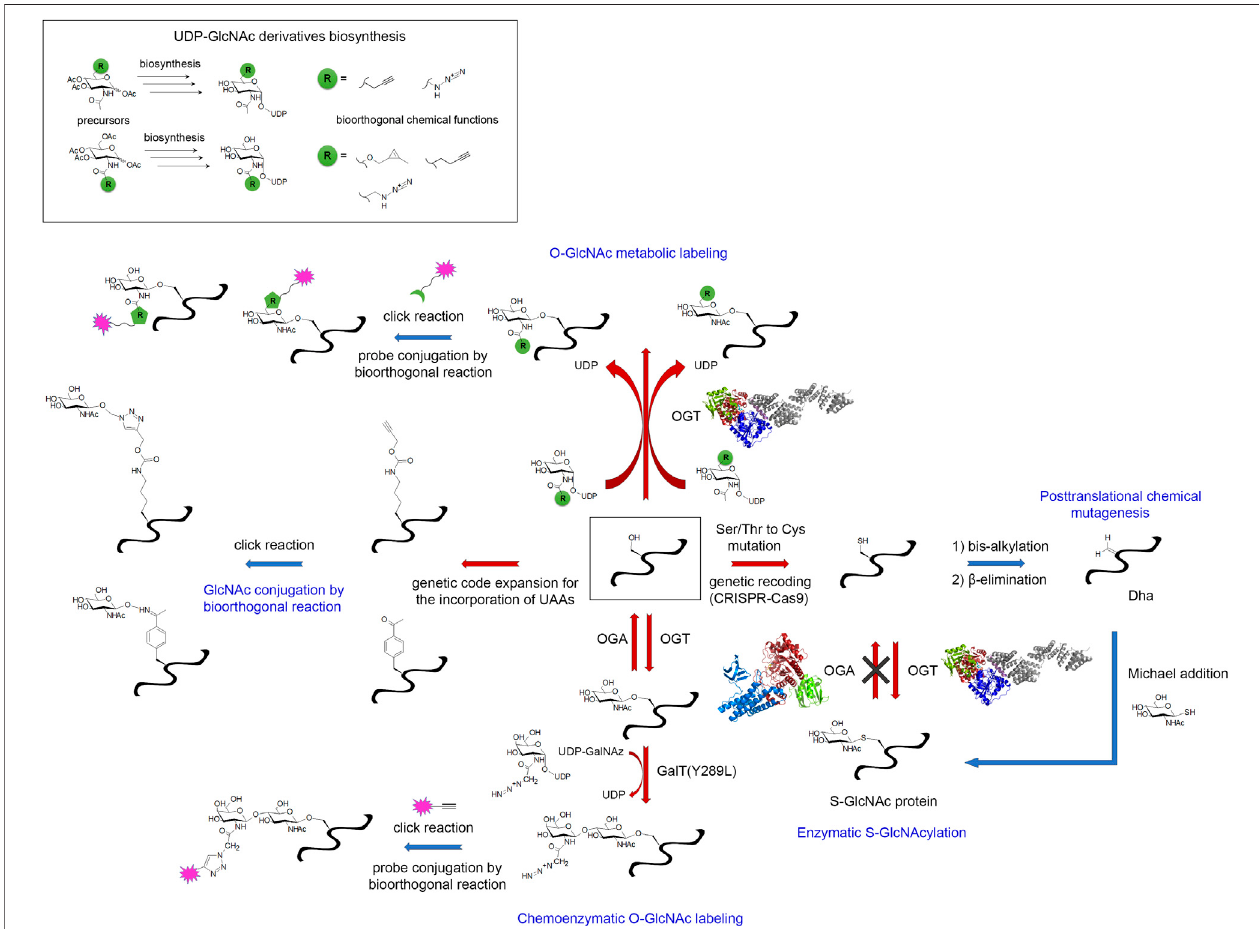
FIGURE 7 | Posttranslational chemical mutagenesis, genetic code expansion and chemo-enzymatic reactions for incorporation of O-GlcNAc mimics and derivativesforO-GlcNAc detection/puri fi cation.Chemicalreactionsareindicatedbybluearrowsandenzymaticreactionsbyredarrows.Someexamplesofthemanifold approaches for the incorporation of S-GlcNAc and O-GlcNAc derivatives are given. An extensive review of O-GlcNAc installation and detection can be found in (Saha etal.,2021).Site-speci fi cO-GlcNAc mimicscanbeincorporateddirectlyonthecysteinethiolfunctionafterSer/ThrintoCyssite-directedmutagenesisorusingthe gene-editing tool CRISPR-Cas9. This allows for instance the enzymatic installation of S-GlcNAc mimics with OGT leading to a stable GlcNAc derivative since hydrolysis by OGA is not possible. Alternatively, the engineered cysteine residue may also be an intermediate to provide a bioorthogonal reactive dehydroalanine (Dha) derivative after thiol bis-alkylation and subsequent β -elimination. The Dha handle is amenable to a Michael addition with a GlcNAc-thiol derivative for installation of a S-GlcNAc derivative. A third approach involved the incorporation of unnatural amino acids (UAAs) bearing a reactive handle amenable to “ click ” chemistry, e.g., acetophenone or propargyl-lysine,usingtheambercodonsuppressionstrategyofgeneticcodeexpansionforthesite-speci fi cO-GlcNAcmodi fi cations.CouplingoftheO-GlcNAcmoiety is performed by azide-alkyne[3 +2] cycloaddition. For detection or enrichment ofO-GlcNAcylated proteins, labeling of O-GlcNAc isperformed asa fi rst step either (i)by “ metabolic labeling ” through oligosaccharide engineering that introduces chemical handles (azide, alkyne, ... ) directly on the GlcNAc group for subsequent reaction (via the biosynthesis of UDP-GlcNAc derivatives, depicted in the box) or (ii) by “ chemoenzymatic labeling ” through an enzymatic reaction of the O-GlcNAc group with a mutant of β 1,4-galactosyltransferase (GalT-Y289L) that forms a glycosidic bond with a galactose derivative (GalNAz). In both strategies, the second step is the subsequent conjugation of reactive probes (e.g., fl uorescent probes, mass tag, biotin ... ) for downstream enrichment or detection. The latter processes through a reaction of “ click ” chemistry making use of azide bioorthogonal reactivity through the copper(I)-catalyzed (CuAAC) or strain-promoted azide-alkyne cycloaddition